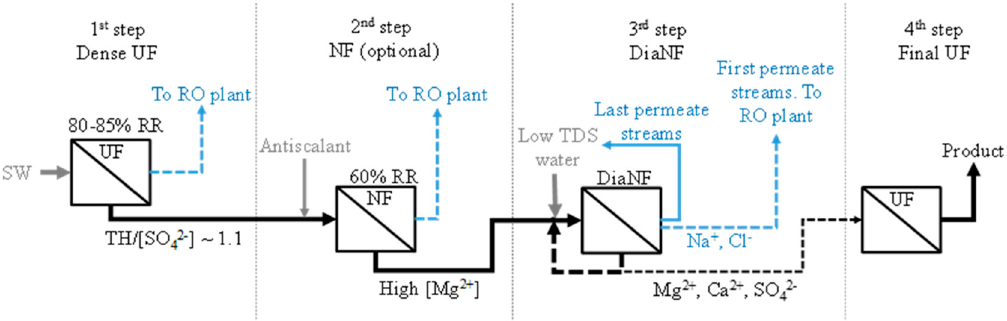
Figure 1. Schematic of the proposed three-step process with a final UF polishing step.